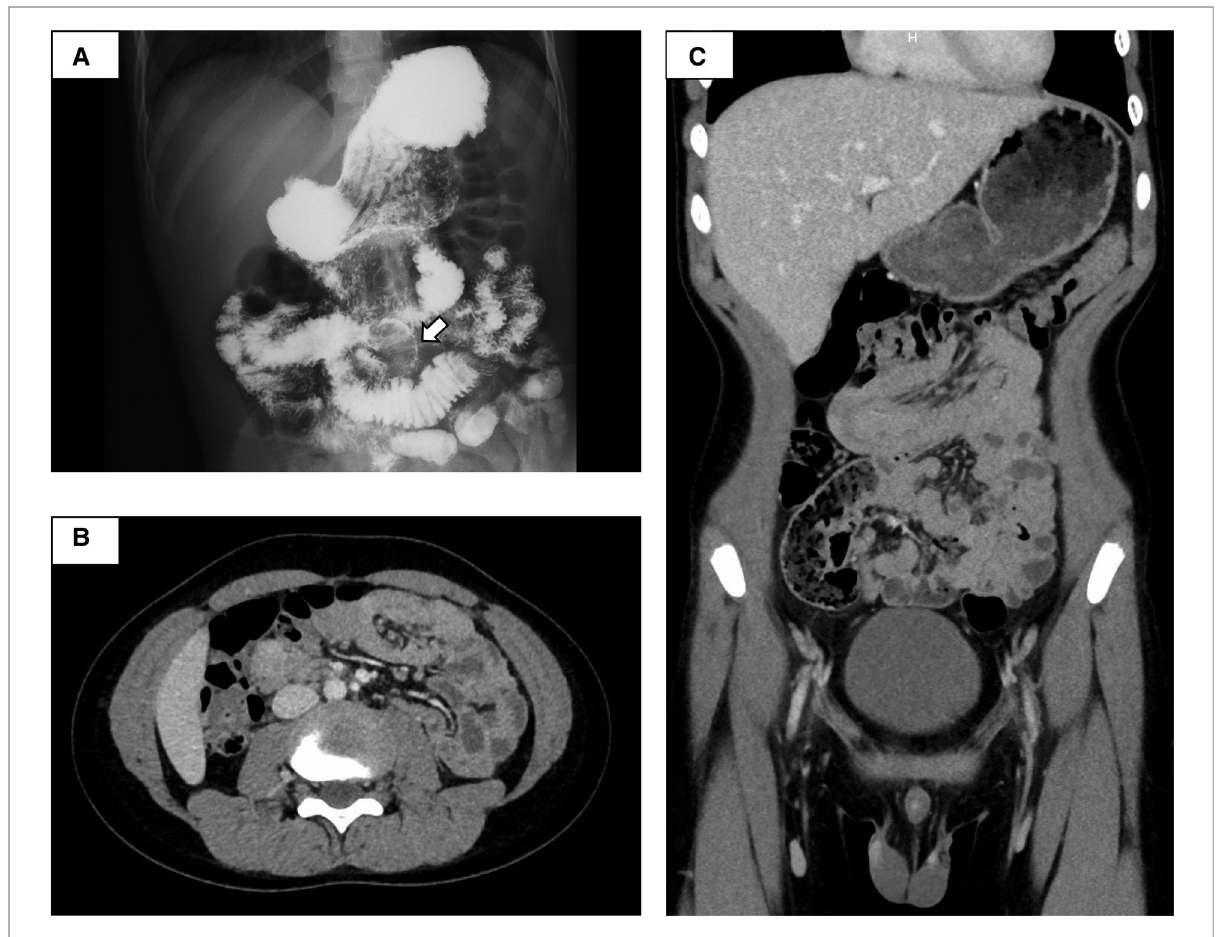
FIGURE 2 Small intestine fl uoroscopy revealed a polyp in the jejunum ( A ), and abdominal computed tomography showed two polyps and intussusception ( B,C ). White arrow,